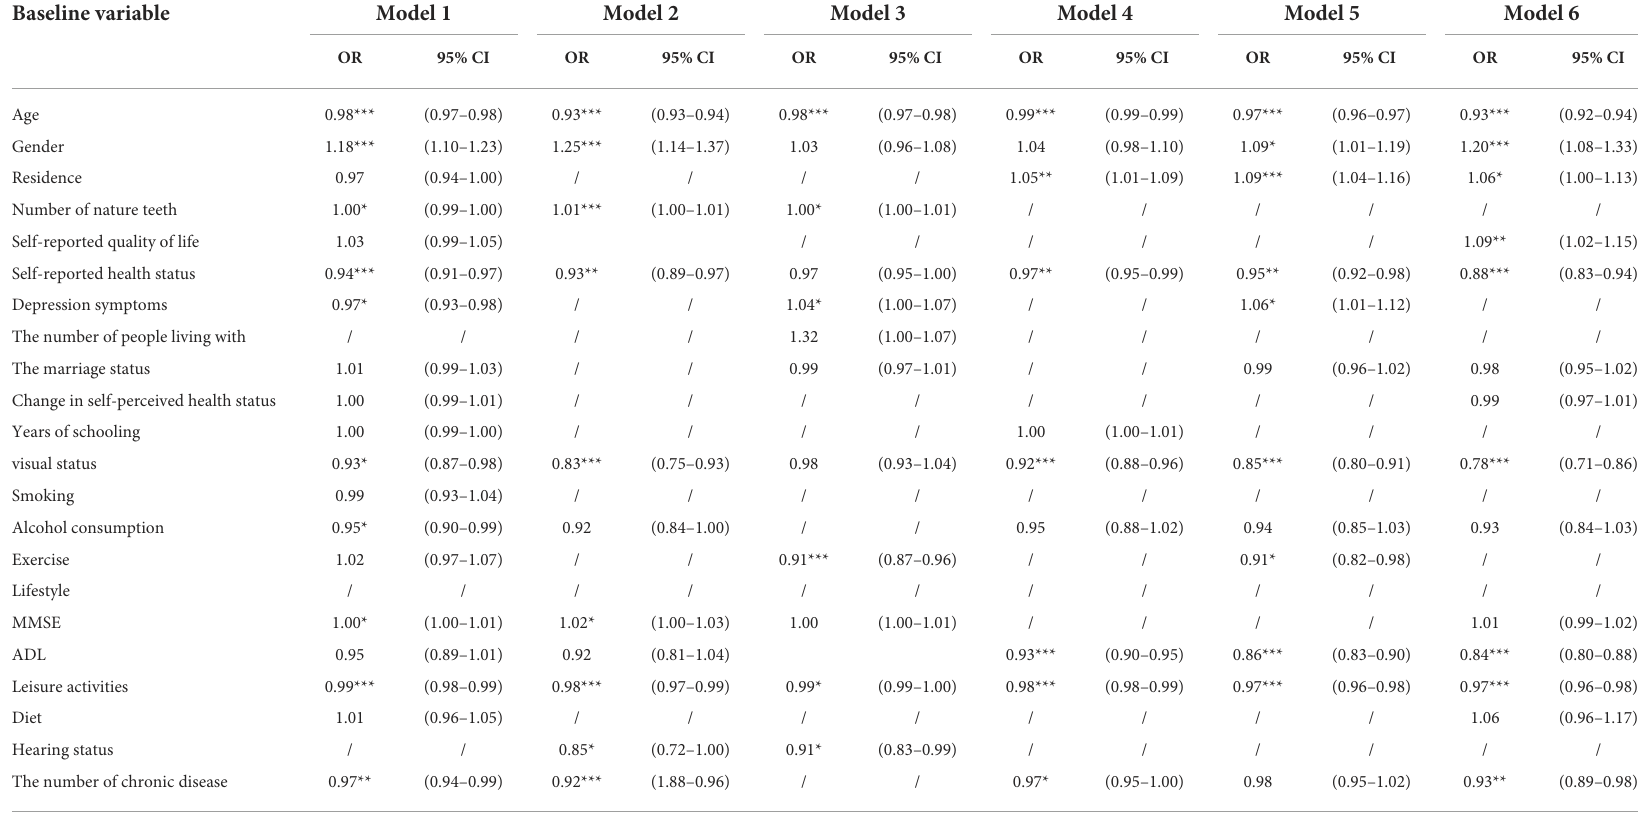
TABLE 4 Associations between different development trends of